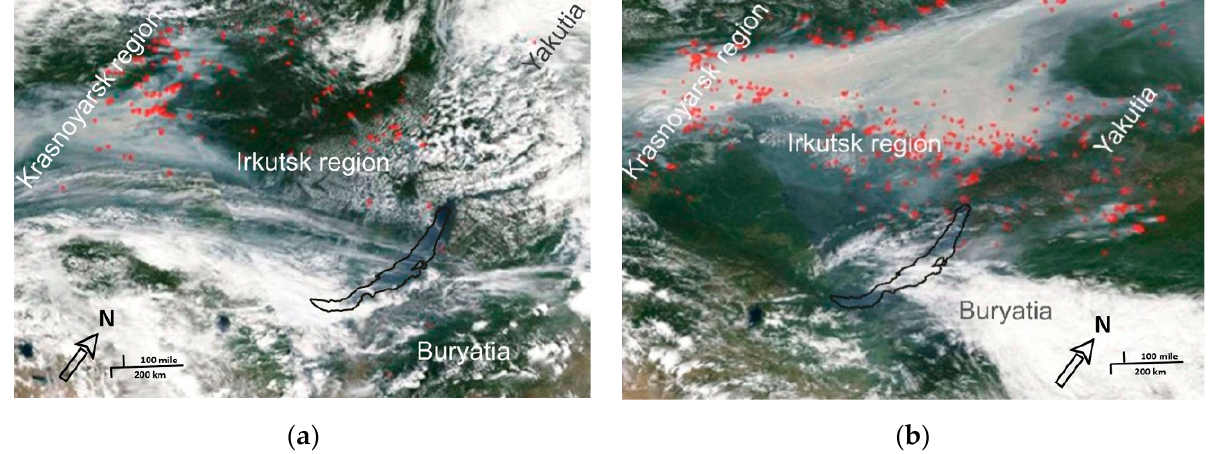
Figure 2. Satellite images of atmospheric smoke over Lake Baikal, July–August 2019 (MODIS): ( a ) 13 July 2019; ( b ) 7 August 2019.